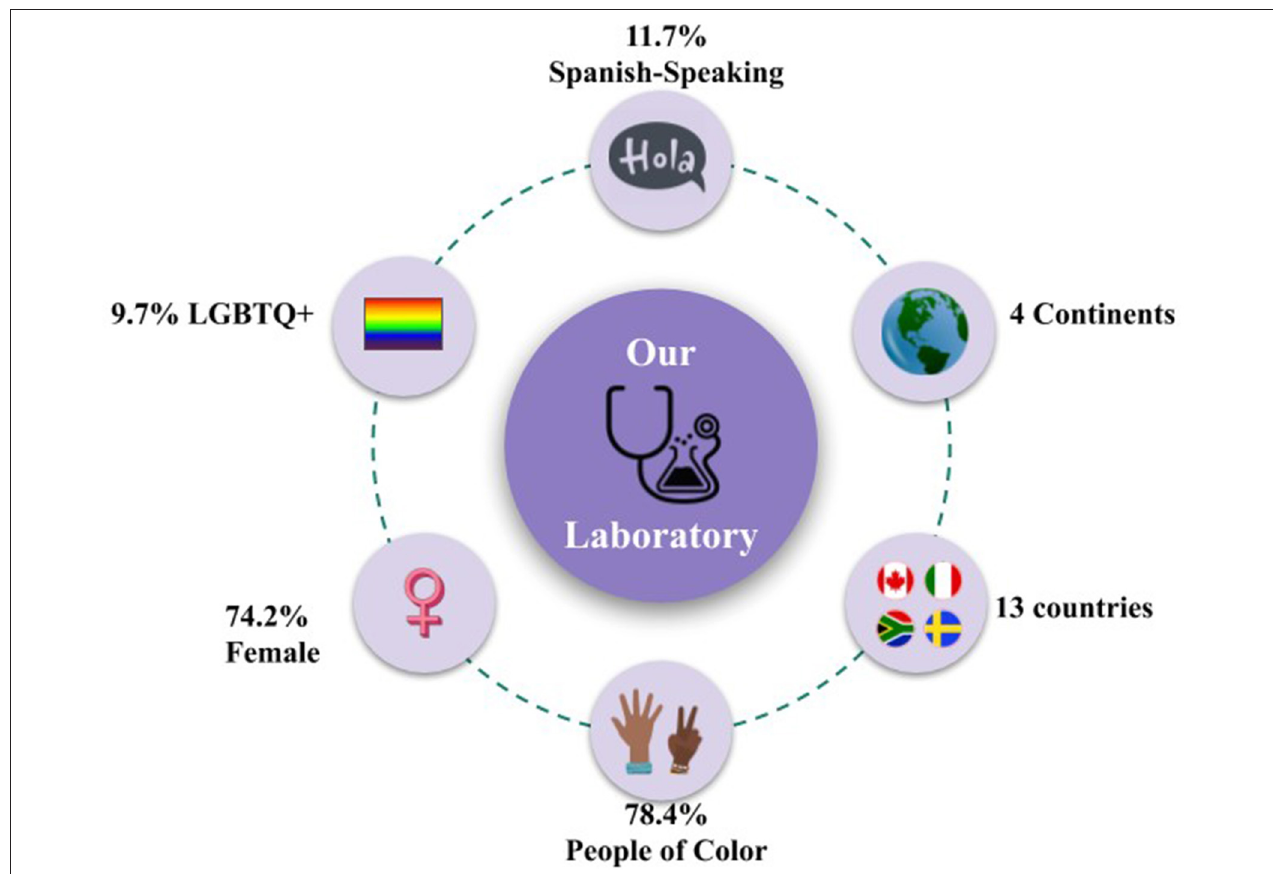
FIGURE 1 | Statistics representing the diversity of our team.